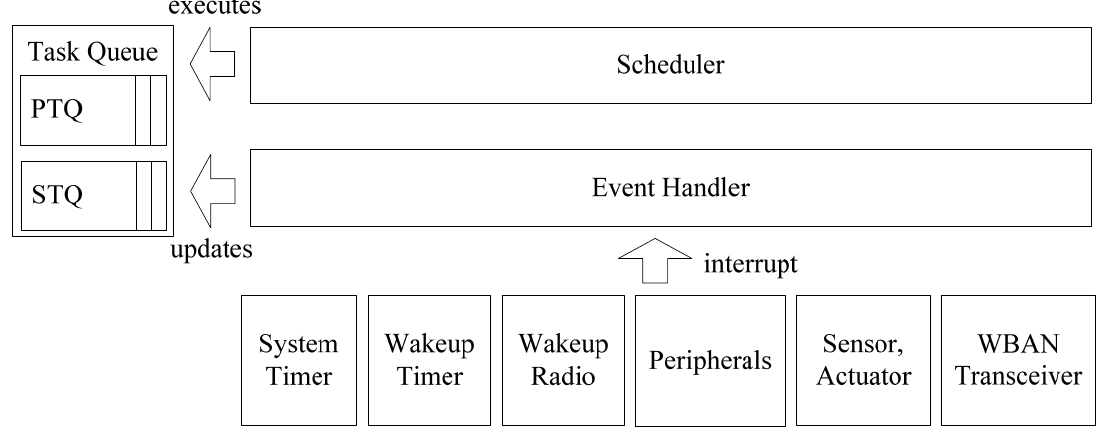
Figure 2. Structure of on-time power-aware scheduling